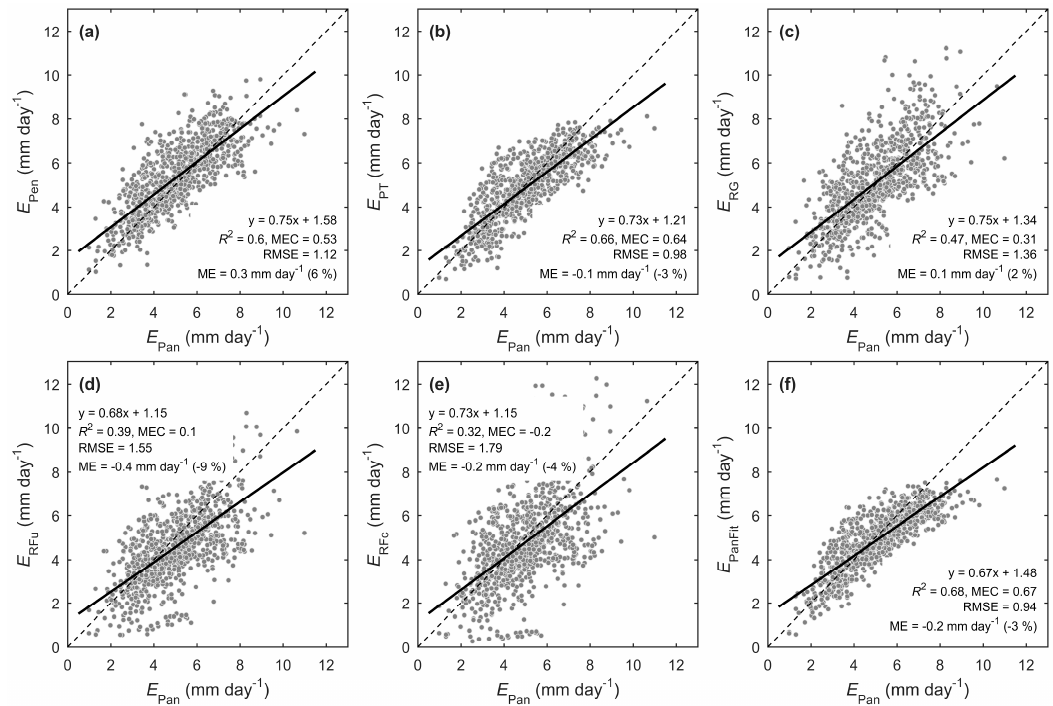
Figure 4. Comparison between observations of monthly mean pan evaporation ( E Pan ) and model predictions of potential evaporation (PE) based on: ( a ) Penman’s model; ( b ) the Priestley–Taylor model; ( c ) reference rates for grasslands based on the Penman–Monteith model; ( d ) reference rates for forests based on the Penman–Monteith model assuming the canopy is moderately coupled to the atmosphere; ( e ) reference rates for forests based on the Penman–Monteith model assuming the canopy is well coupled to the atmosphere; ( f ) linear mixed-effects model fit to monthly pan evaporation ( E PanFit ).